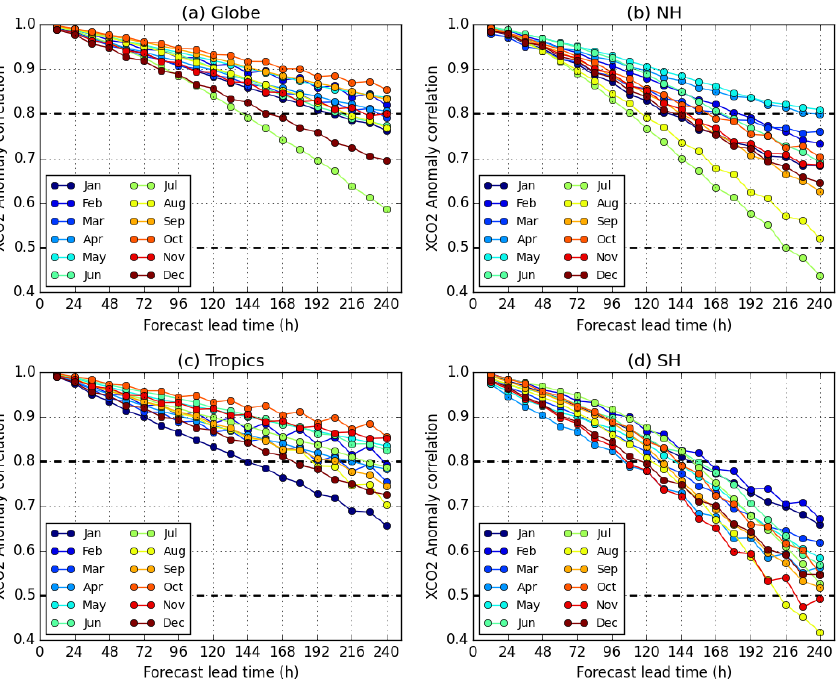
Figure 8. Anomaly correlation coefficient (ACC) of the forecast compared to its own analysis as a function of the forecast lead time and for each month: (a) global ACC, (b) ACC for the Northern Hemisphere (20–90 ◦ N), (c) ACC for the tropics (20 ◦ S–20 ◦ N), and (d) ACC for the Southern Hemisphere (90–20 ◦ S). Each month is represented by a different colour (see inset